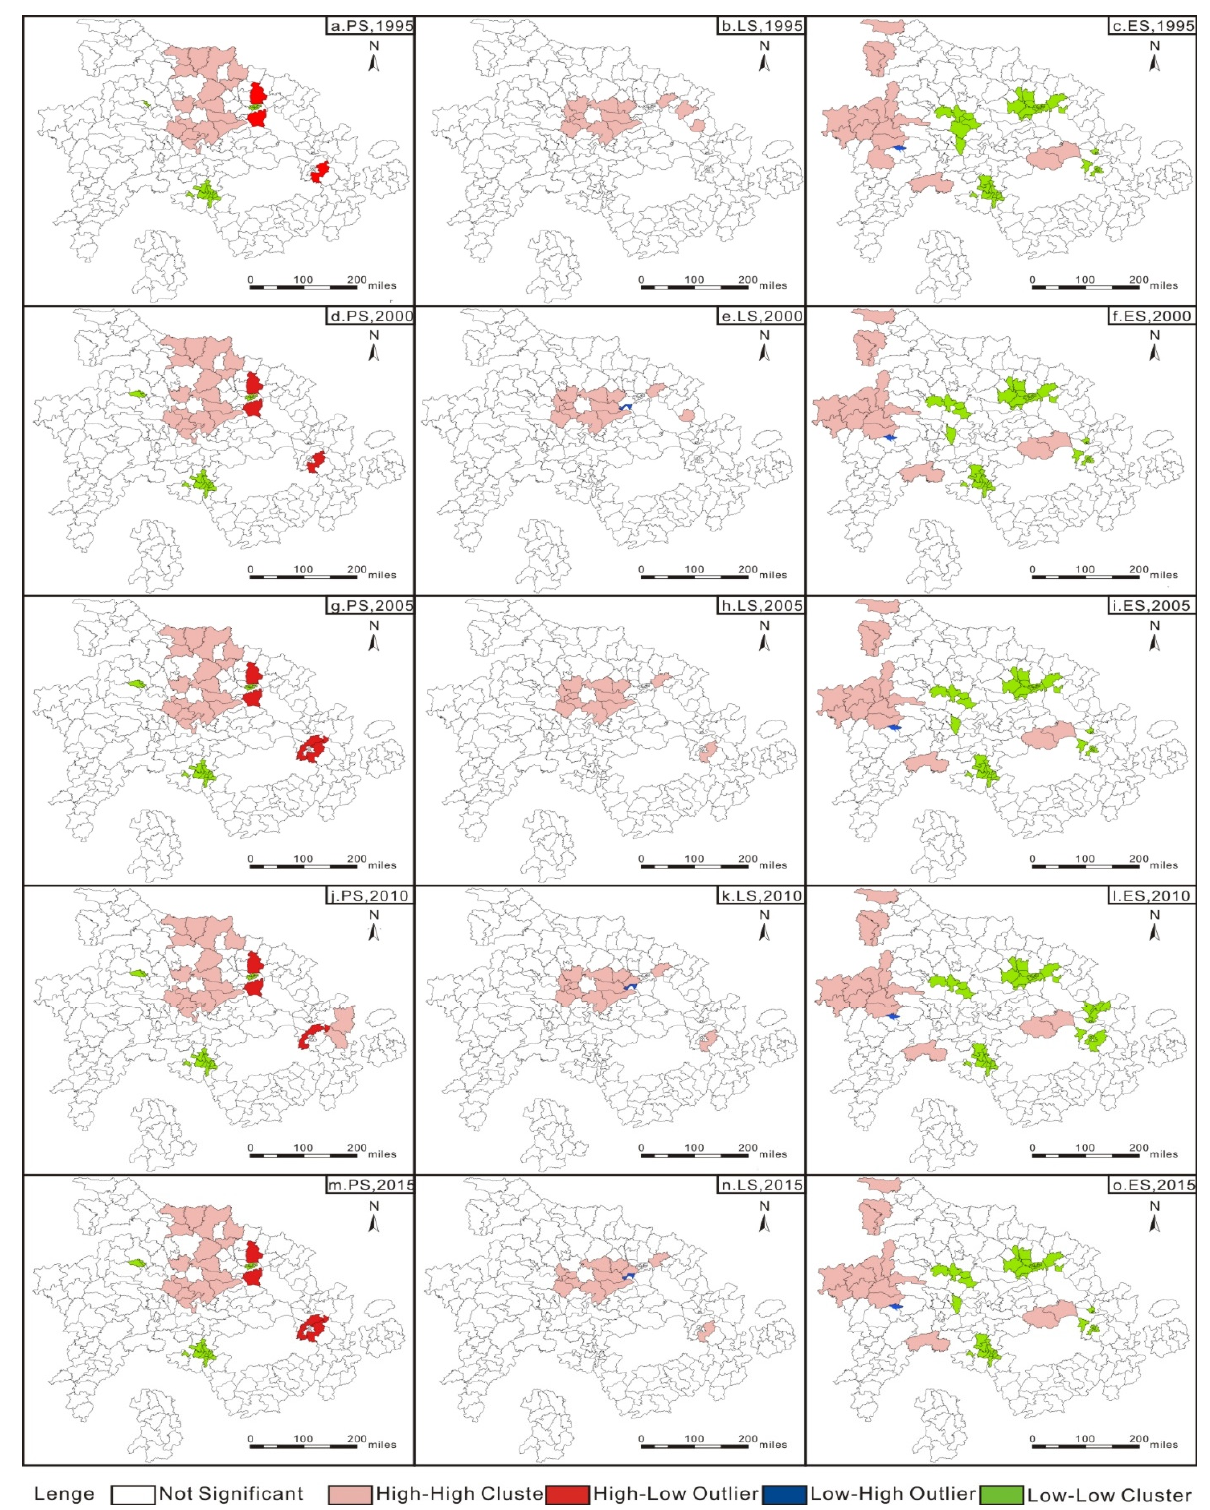
Figure 3. Local spatial autocorrelation results of the PLES of the resource-based cities, 1995–2015.